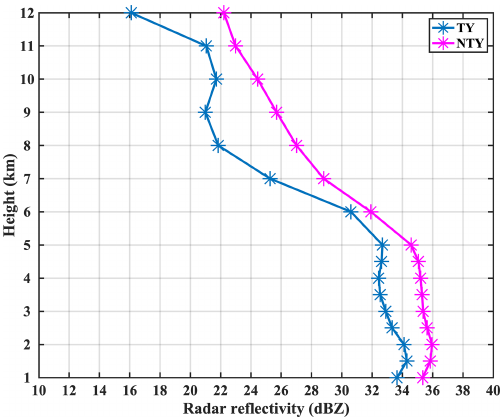
Figure 18. Mean radar reflectivity profiles of typhoon (TY) and non-typhoon (NTY)